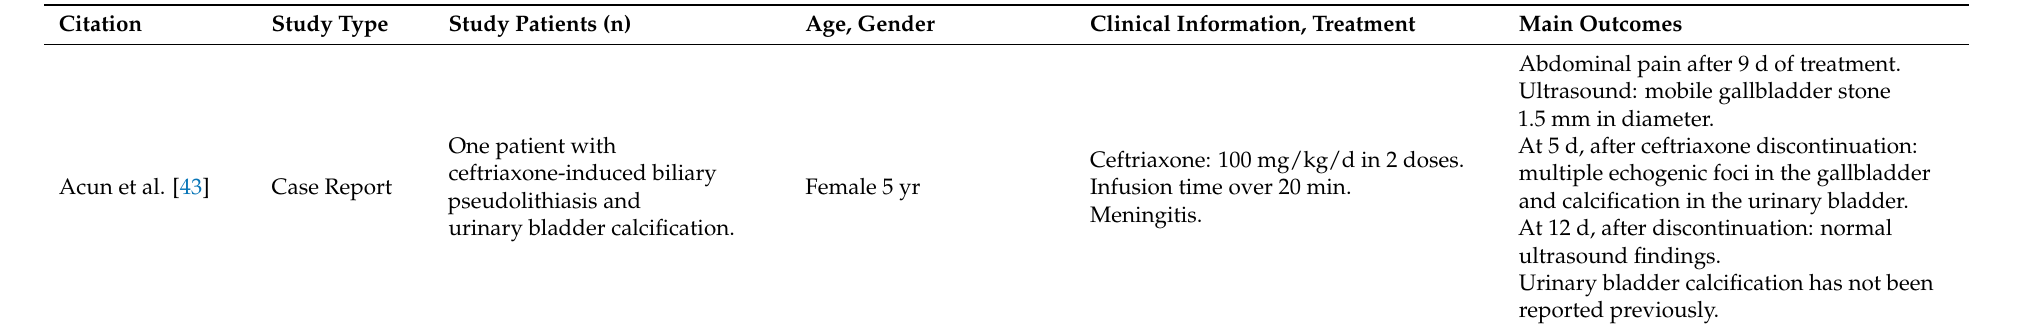
Table 3. Summary of the main findings from the articles included in the study regarding combined biliary and urinary lithiasis